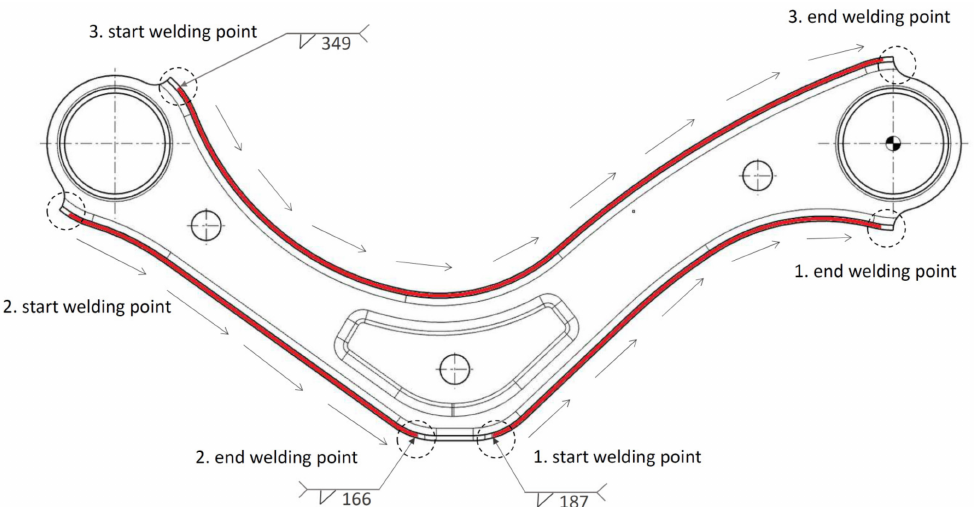
Figure 5. Location of welds and their order during